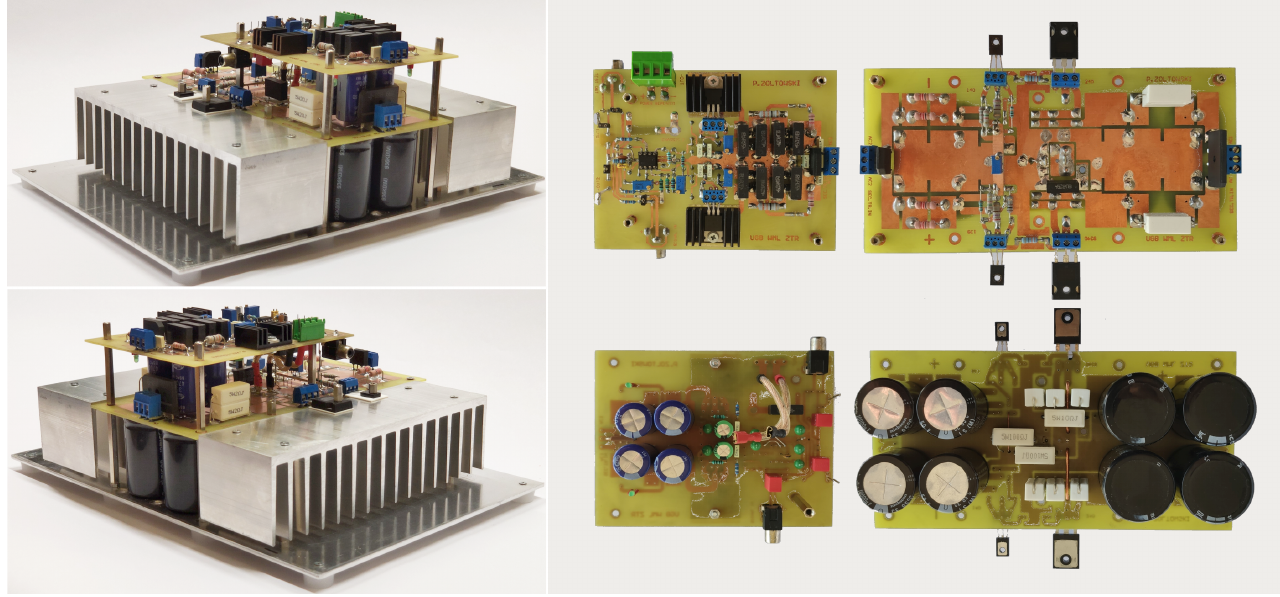
Figure 4. Sample views of the LF power amplifier module.